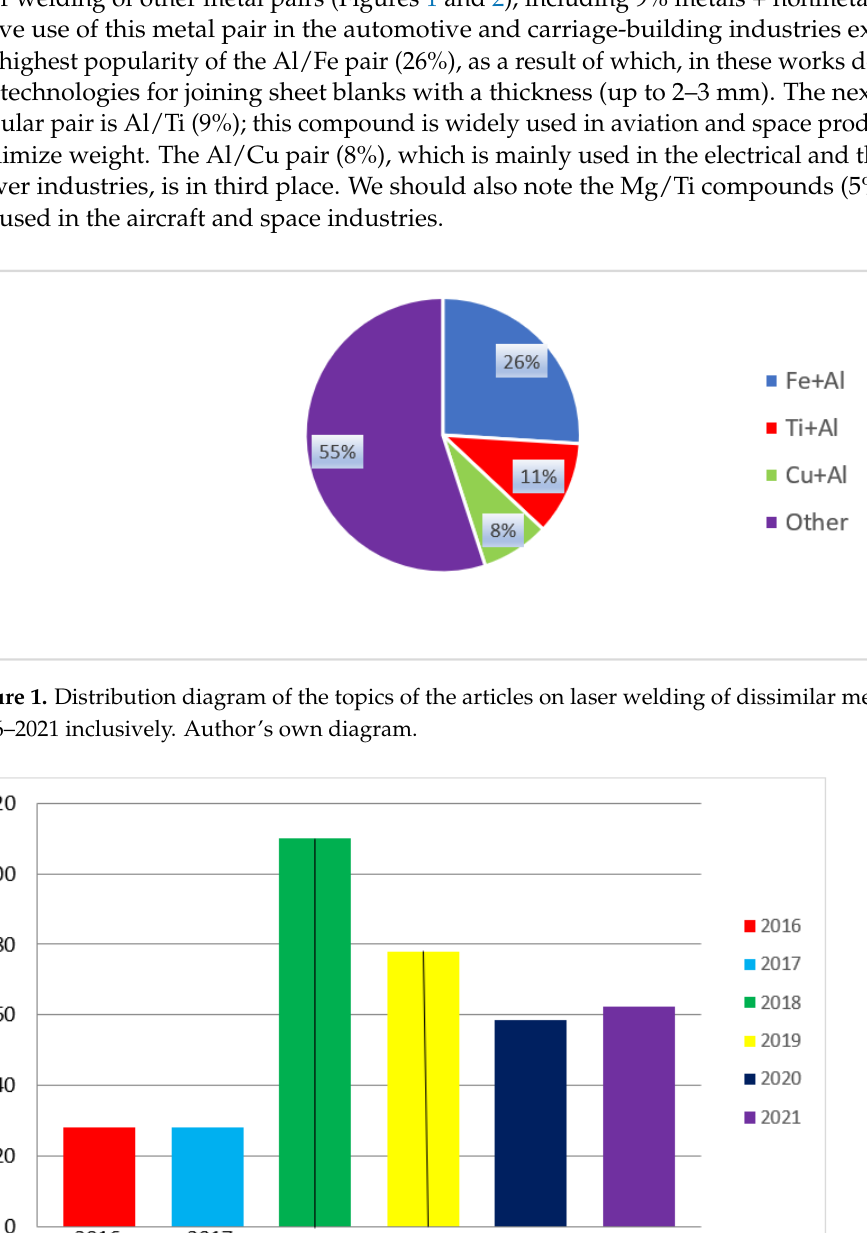
Table 2. Physical properties of Al, Fe, Ti, Cu [6].